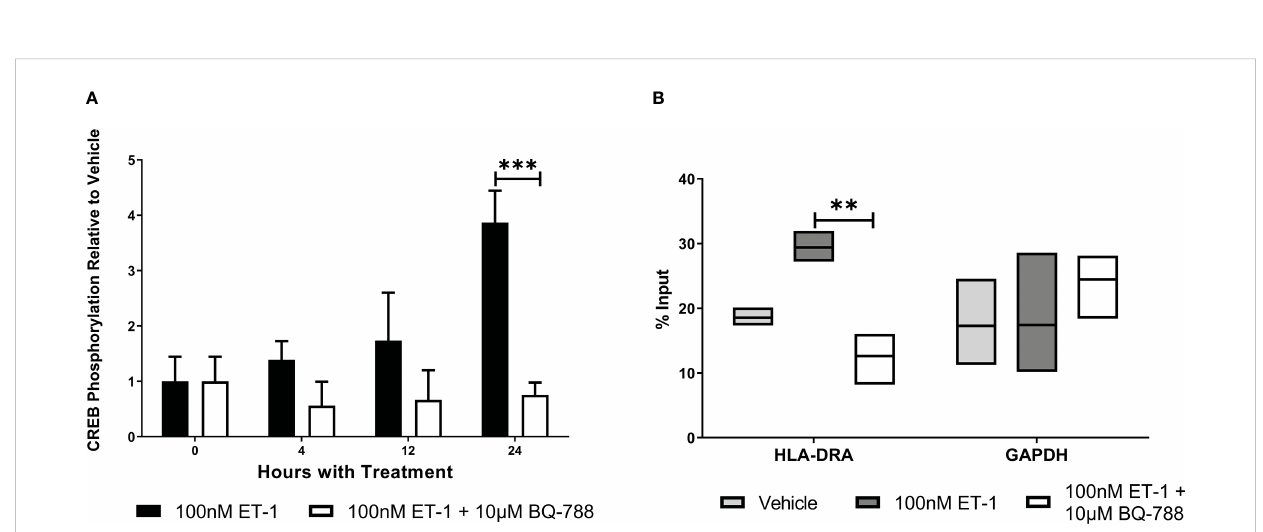
FIGURE 4 ET-1 stimulates MHC expression by CREB activation. (A) The ratio of phospho-CREB (p-CREB) to total CREB in EA.hy926 cells treated with 100 nM ET-1 and 100 nM ET-1 + 10 µM BQ-788 for 24 hours at 37°C. (B) CREB chromatin immunoprecipitation. CREB is associated with MHC class II promoter in EA.hy926 cells treated with 100 nM ET-1 and 100 nM ET-1 + 10 µM BQ-788 for 24 hours at 37°C. Lysates were immunoprecipitated with antibodies against CREB, and DNA was isolated and analyzed via real-time PCR. Values were normalized to the total amount of promoter DNA added to the reaction (input). Input = 5% of total cell lysate. Data represent mean ± SD (n = 3). **p < 0.01, ***p < 0.001, 100nM ET-1 versus 100nM ET-1 with 10µM